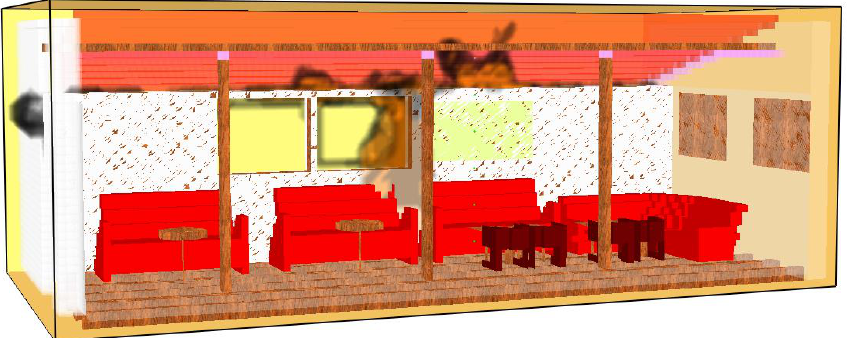
Figure 15. The spread of the fire inside the restaurant floor, through the window, and the ignition of the furniture in the room (sofas located nearby windows).